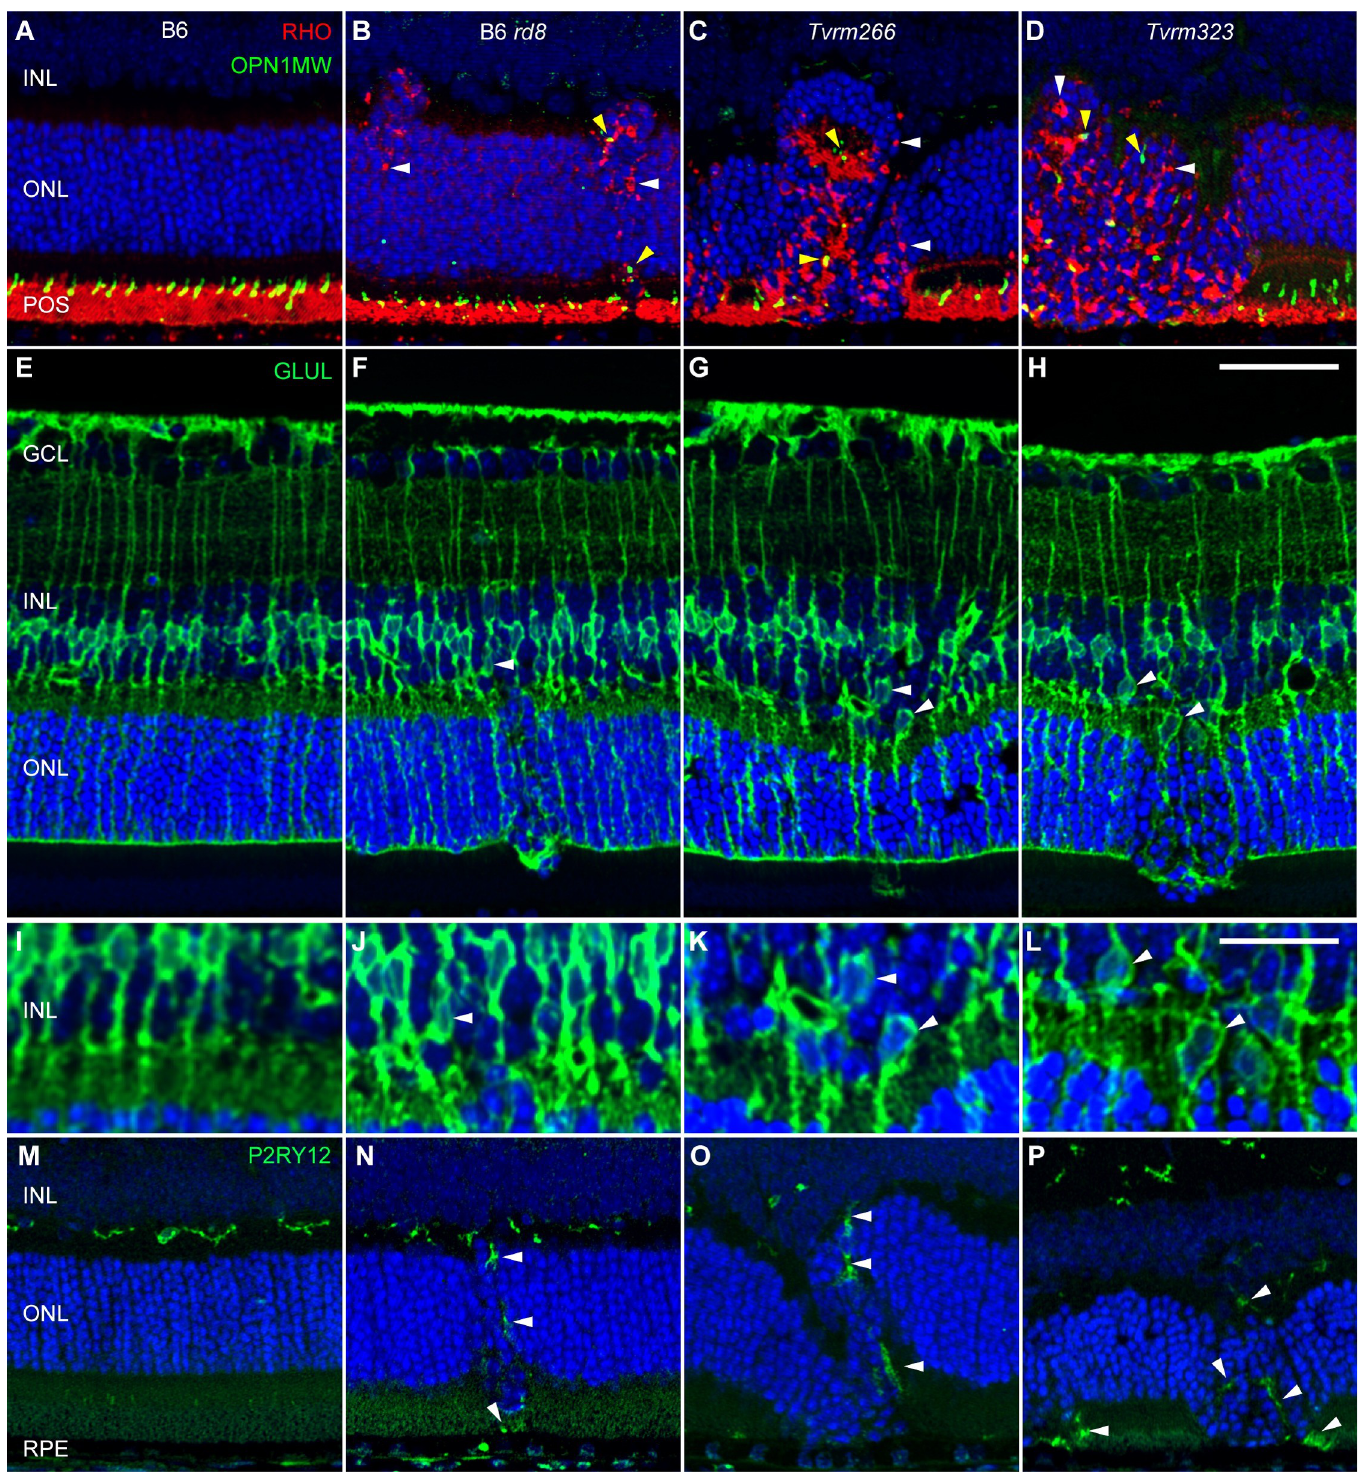
Fig 6. Ectopic retinal cells in dysplastic lesions at one month of age. Retinal sections of 7–9 B6 (A, E, I, M), B6 rd8 (B, F, J, N), Tvrm266 (C, G, K, O), and Tvrm323 (D, H, L, P) mice were examined for each panel of markers studied. A–D. Staining with rhodopsin (RHO, red ) and M cone opsin (OPN1MW, green ) antibodies indicated a normal location of rod and cone outer segments in B6 mice (A) but an ectopic location at dysplastic lesions of Crb1 rd8 mutants (B–D; white and yellow arrowheads , respectively). E–H. Glutamine synthetase (GLUL, green ) antibodies revealed Mu¨ller cell soma at the center of the INL in B6 mice (E, detailed in I) but displaced toward the